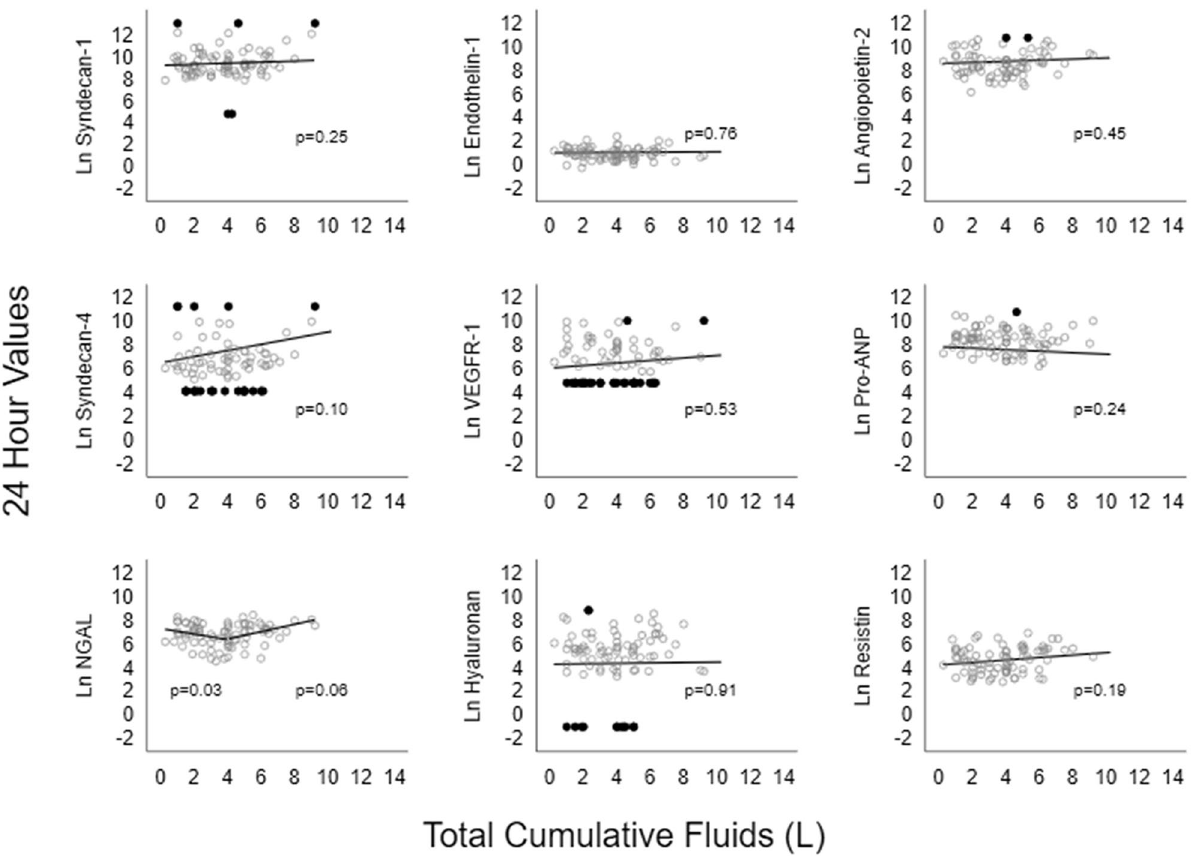
Figure 2. Sensitivity analysis (excluding two outlier cases) of relationship between volume of intravenous fluid and each biomarker at T24 adjusted for age, sex, mean arterial blood pressure, lactate, Charlson score, SOFA score, source of infection and recruitment site. Circles – data points, Dots – censored values.